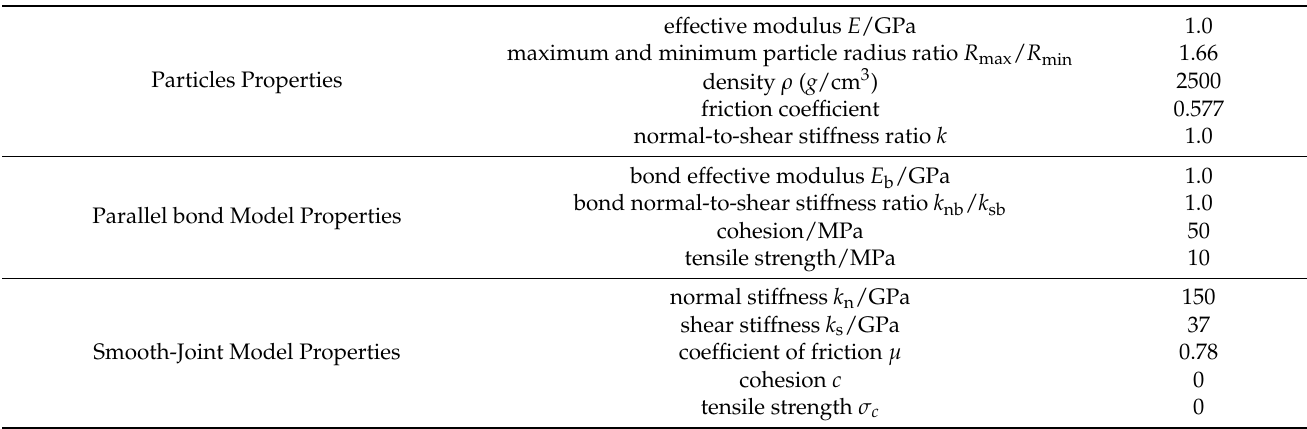
Table 1. Calibration of microscopic